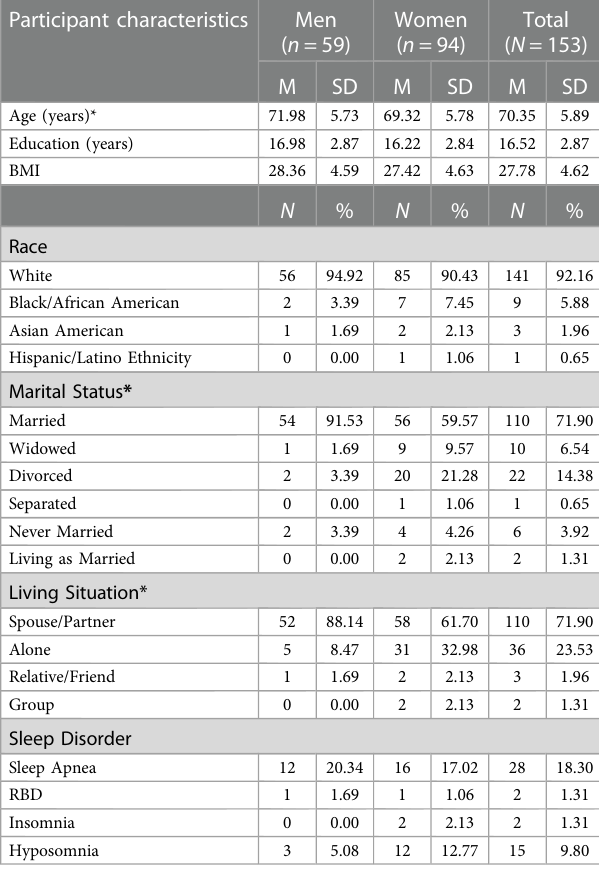
6.83 h, SD = 1.04 h) and the duration of wake after sleep onset